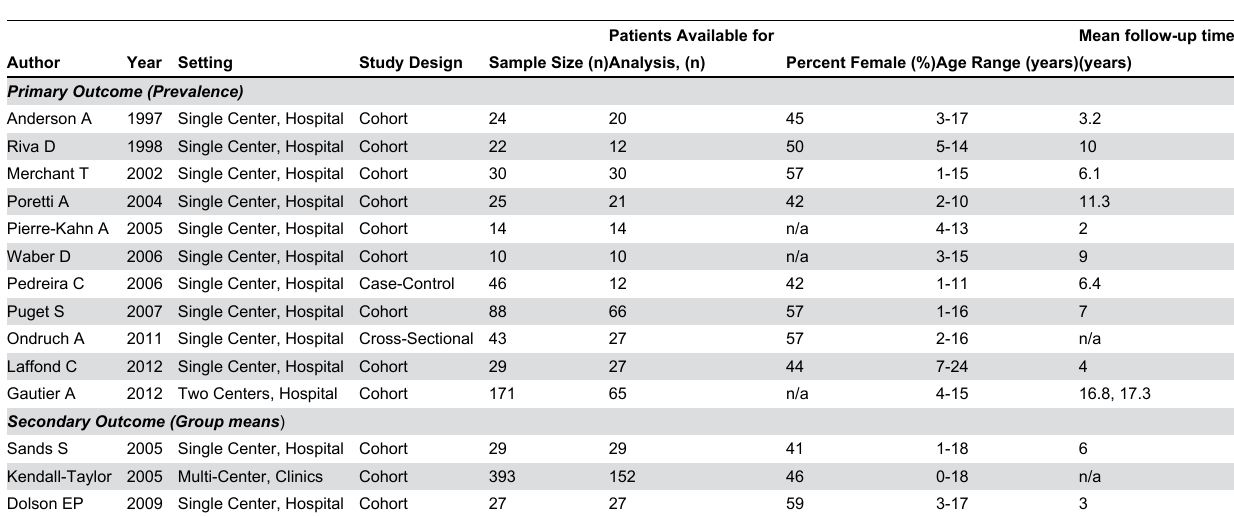
Table 1. General characteristics of the included studies.